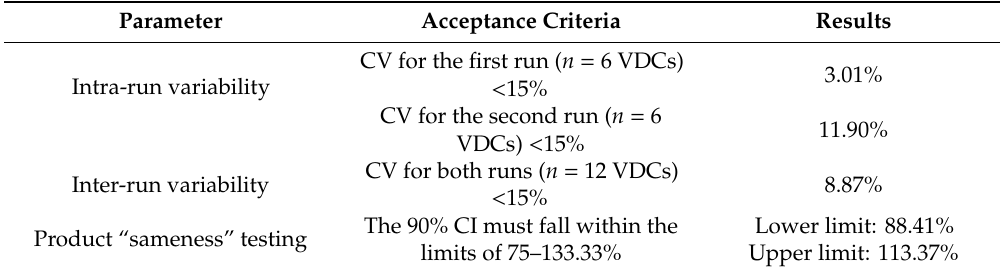
Table 2. Pre-defined acceptance criteria and results for the performance verification test